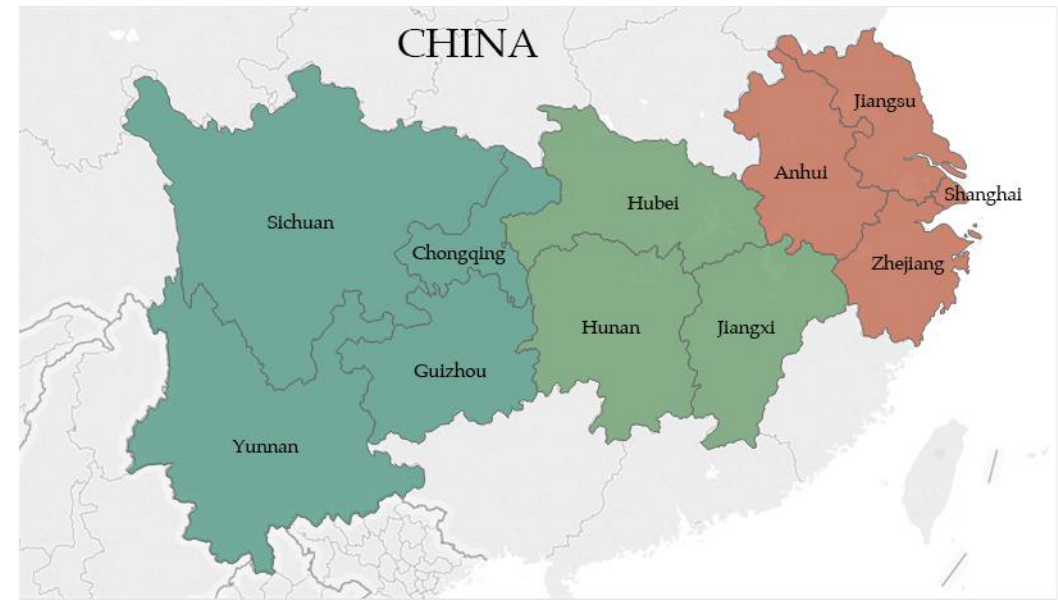
Figure 6. The Study area.